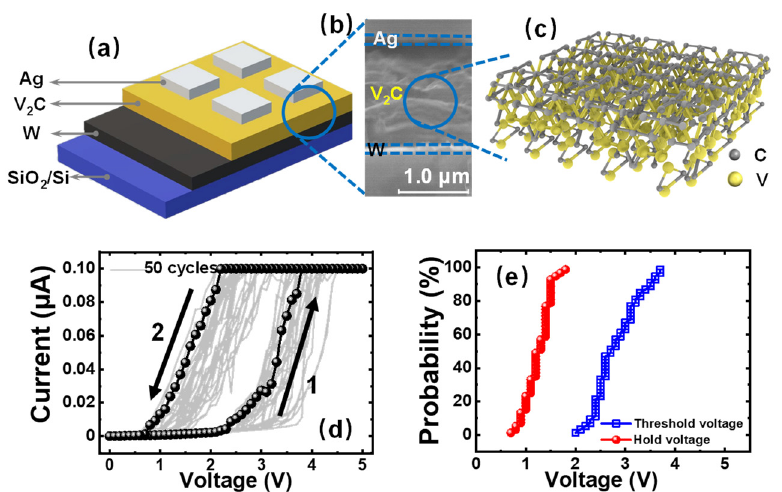
Figure 2. Schematic and DC electrical performances of V 2 C-based memristors. ( a ) Schematic illustration of the proposed Ag/V 2 C/W memristors. ( b ) Cross-sectional SEM image of the fabricated memristor. ( c ) Atomic structure of few layered V 2 C MXene. ( d ) Fifty sequential cycles of I-V characteristics of V 2 C memristor with linear scale. ( e ) Distribution of threshold and hold voltage extracted from Figure 2d.